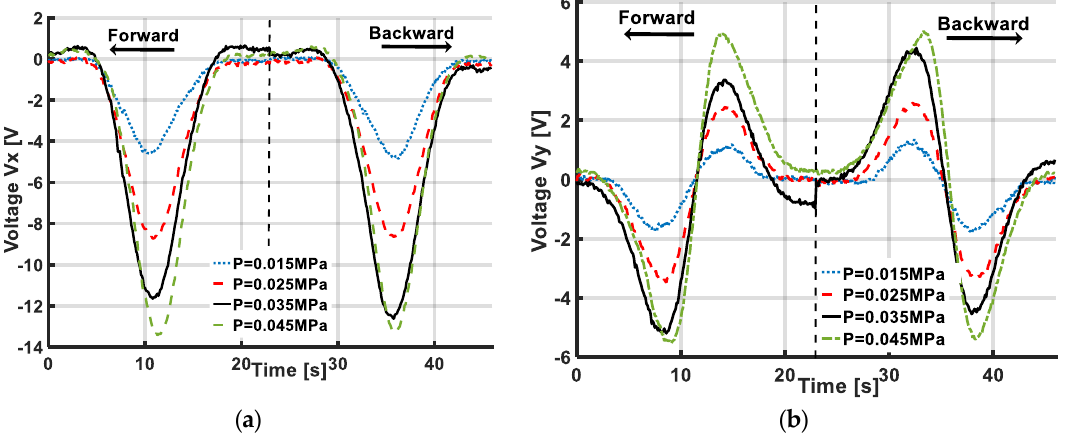
Figure 26. Accelerometer’s output voltage with di ff erent pressurizations in Y-sliding case. With higher pressure value, sensing system is more sensitive to sliding action. Nonetheless, high pressurization is relatively ine ff ective. ( a ) Output voltage V x ( V ) with di ff erent pressurizations. ( b ) Output voltage V y ( V ) with di ff erent pressurizations.